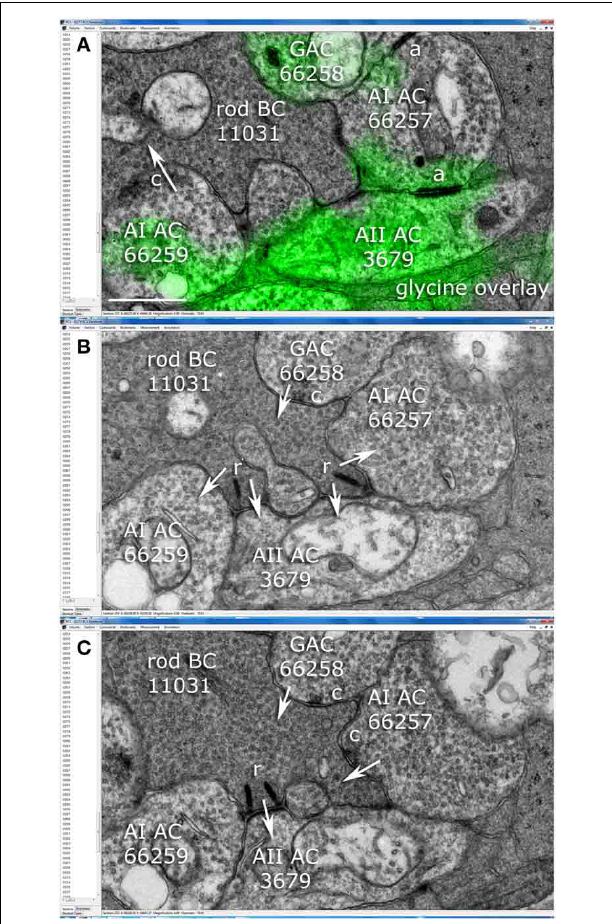
FIGURE 4 | Synaptic relationships among amacrine and rod bipolar cells in the Viking connectome viewer. (A) Slice z277: overlay of glycine channel and TEM. AI cell 66257 forms adherens junctions (a) with AII cell 3679 and glycinergic amacrine cell (GAC) 66258. AI cell 66259 forms a conventional synapse (c) onto postsynaptic target (arrow) rod bipolar cell (rod BC) 11031. (B) Slice z274: Rod BC forms two synaptic ribbons (r) onto postsynaptic targets AII 3679, AI 66257 and AI 66259.GAC 66258 is presynaptic to rod BC 11031. (C) Slice z272: rod BC forms a third ribbon with AII 3679 and AI 66257 forms a feedback synapse. Scale (A) , 500nm.